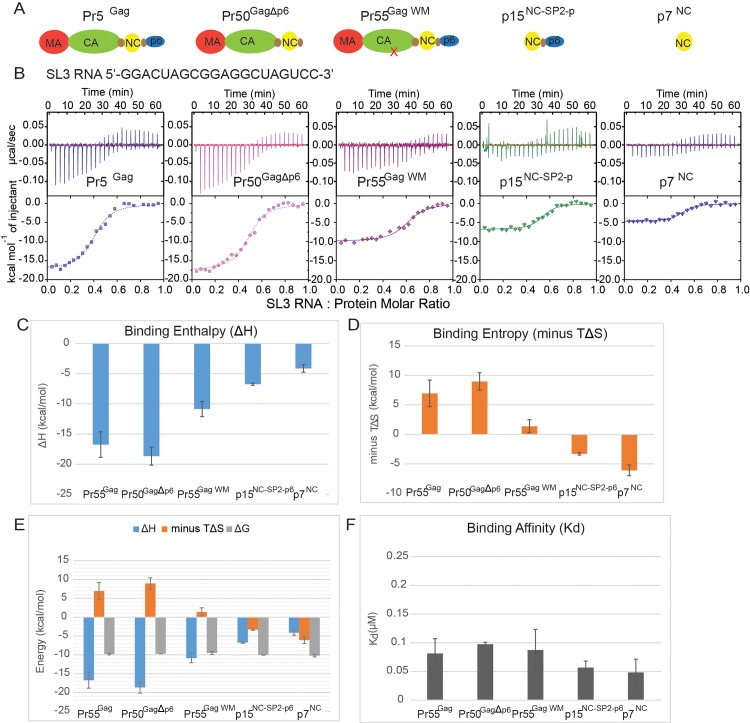
Binding between Psi SL3 RNA and Pr55Gag is an energetically favourable reaction and the level of energy released is enhanced by the oligomerization capacity of Pr55Gag.(A) Schematic representation of domain arrangement in Gag proteins (Pr55Gag, Pr50GagΔp6, Pr55Gag WM) and processed NC proteins (p15NC-SP2-p6 and p7NC) used in this study (B) The top panels show the differential heat released following baseline subtraction and the bottom panels show representative ITC binding curve indicating heat released per mole of oligonucleotide titrated when Psi SL3 RNA (40 μM) was injected in 1.5 μL aliquots into 8 μM of Pr55Gag, Pr50GagΔp6, Pr55Gag WM, p15NC-SP2-p6 or p7NC, respectively. Calculated (C) binding enthalpies (ΔH), (D) binding entropies (minus TΔS), (E) Gibb’s free energies (ΔG) and (F) binding affinities (kd) from ITC binding curves fitted to a one-site interaction model plotted for replicate Gag protein interactions with Psi SL3 RNA (n = 3). The mean value is plotted and the error bars represent the SEM.